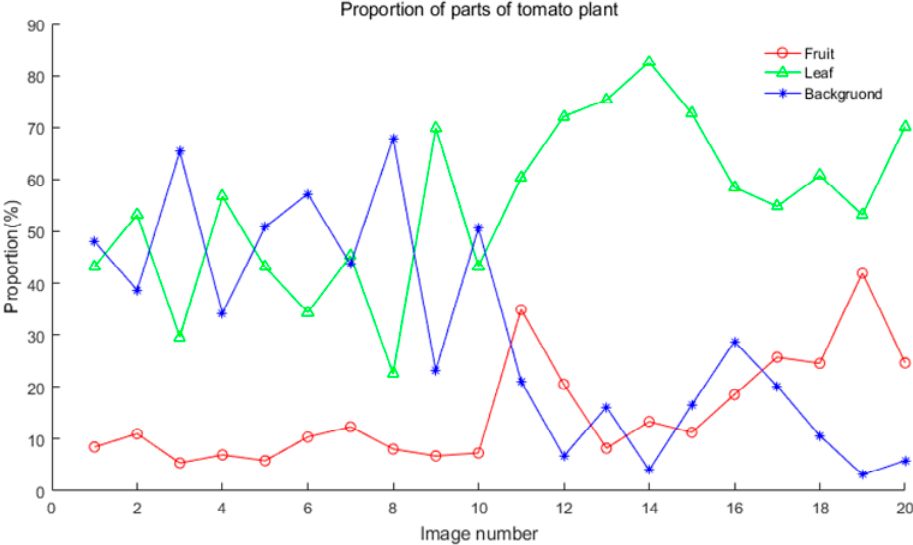
Figure 6. Proportion of tomato organs.